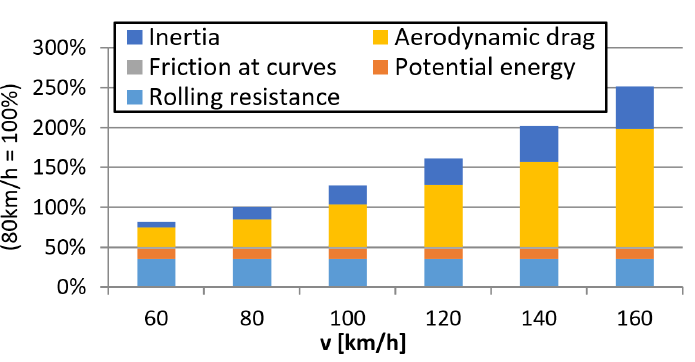
Figure 1. Specific energy consumption of a container train at different speeds according to